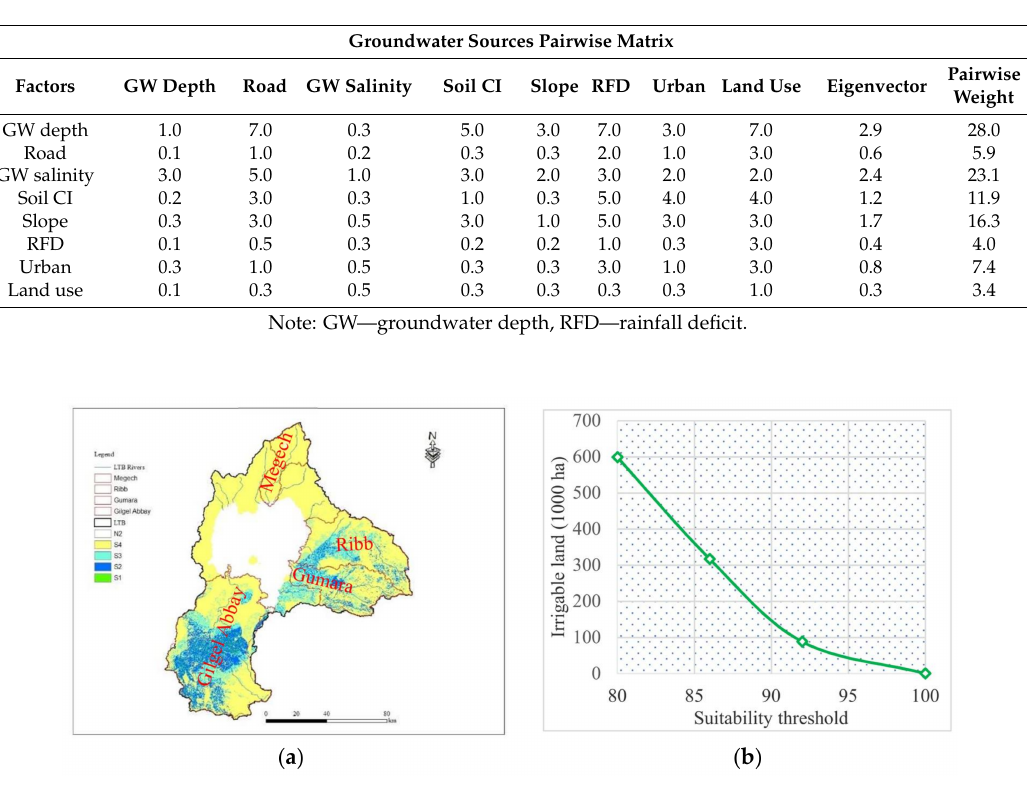
Figure 11. Irrigable land from rivers ( a ) 85% threshold; and ( b ) various